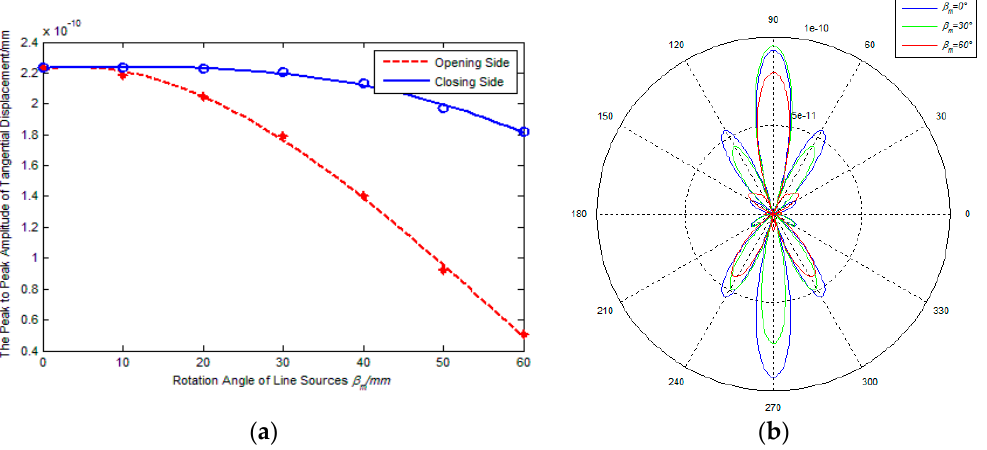
Figure 5. Effects of β m on performance of PPM EMATs ( d = 20 mm); ( a ) β m -signal amplitude; ( b ) β m -radiated acoustic field.